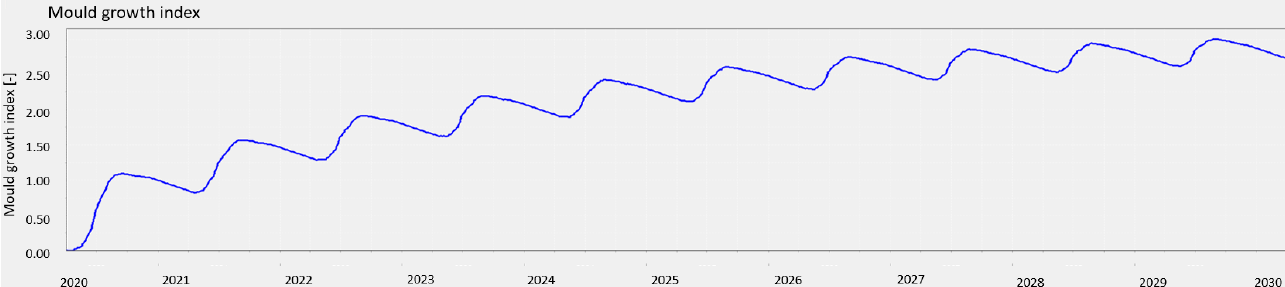
Figure 13. Graph showing mould growth results and mould index within the insulation layer of the 7 ‐ star clay masonry veneer wall with a vapour ‐ permeable membrane—western